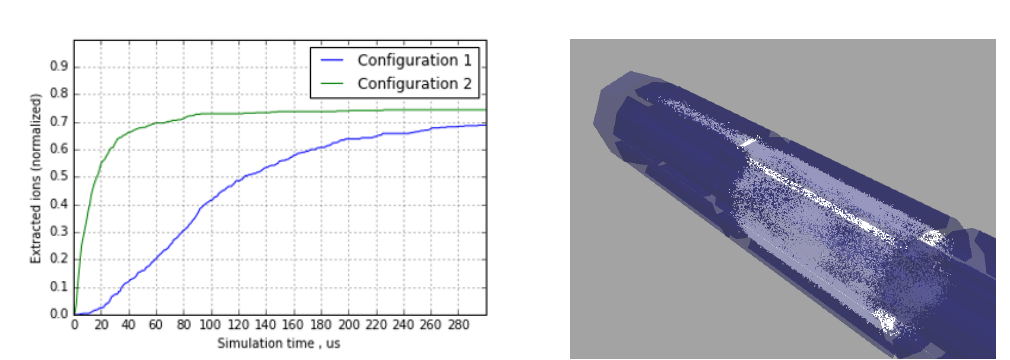
Figure 5. Left panel: total amount of ions extracted from the device relative to initial amount. Azimuthal potential gradient is absent in Configuration 1 and present in Configuration 2. The gradient significantly speeds- up ion extraction. Right panel: ion distribution in TESIS during extraction. Ion beam in the extraction area is visible in the upper-left corner and the ion trap region in the